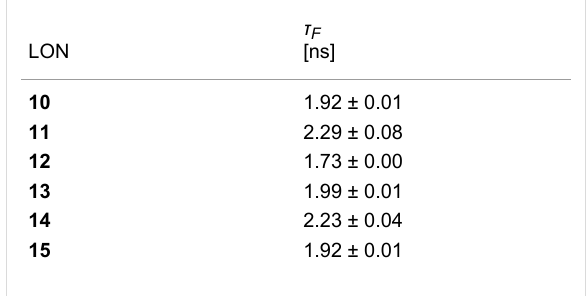
Table 6: Fluorescence lifetime values of LONs 10 – 15